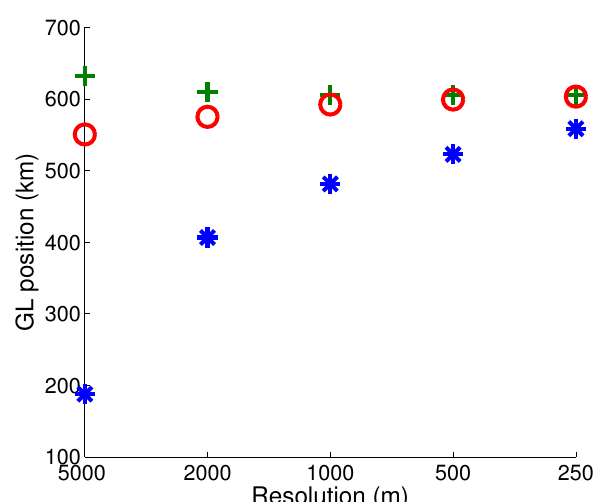
Fig. A1. Grounding line discretization. Grounding line exact location (a), no sub-element parameterization (NSEP, b), sub-element parame- terization 1 (SEP1, c), sub-element parameterization 3 (SEP2, d) and sub-element parameterization 3 (SEP3,e).